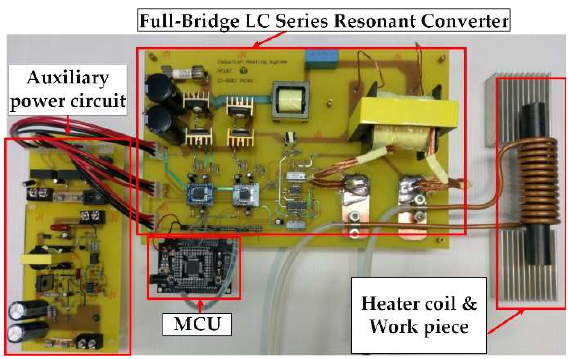
Figure 18. A prototype of the proposed induction heating system.